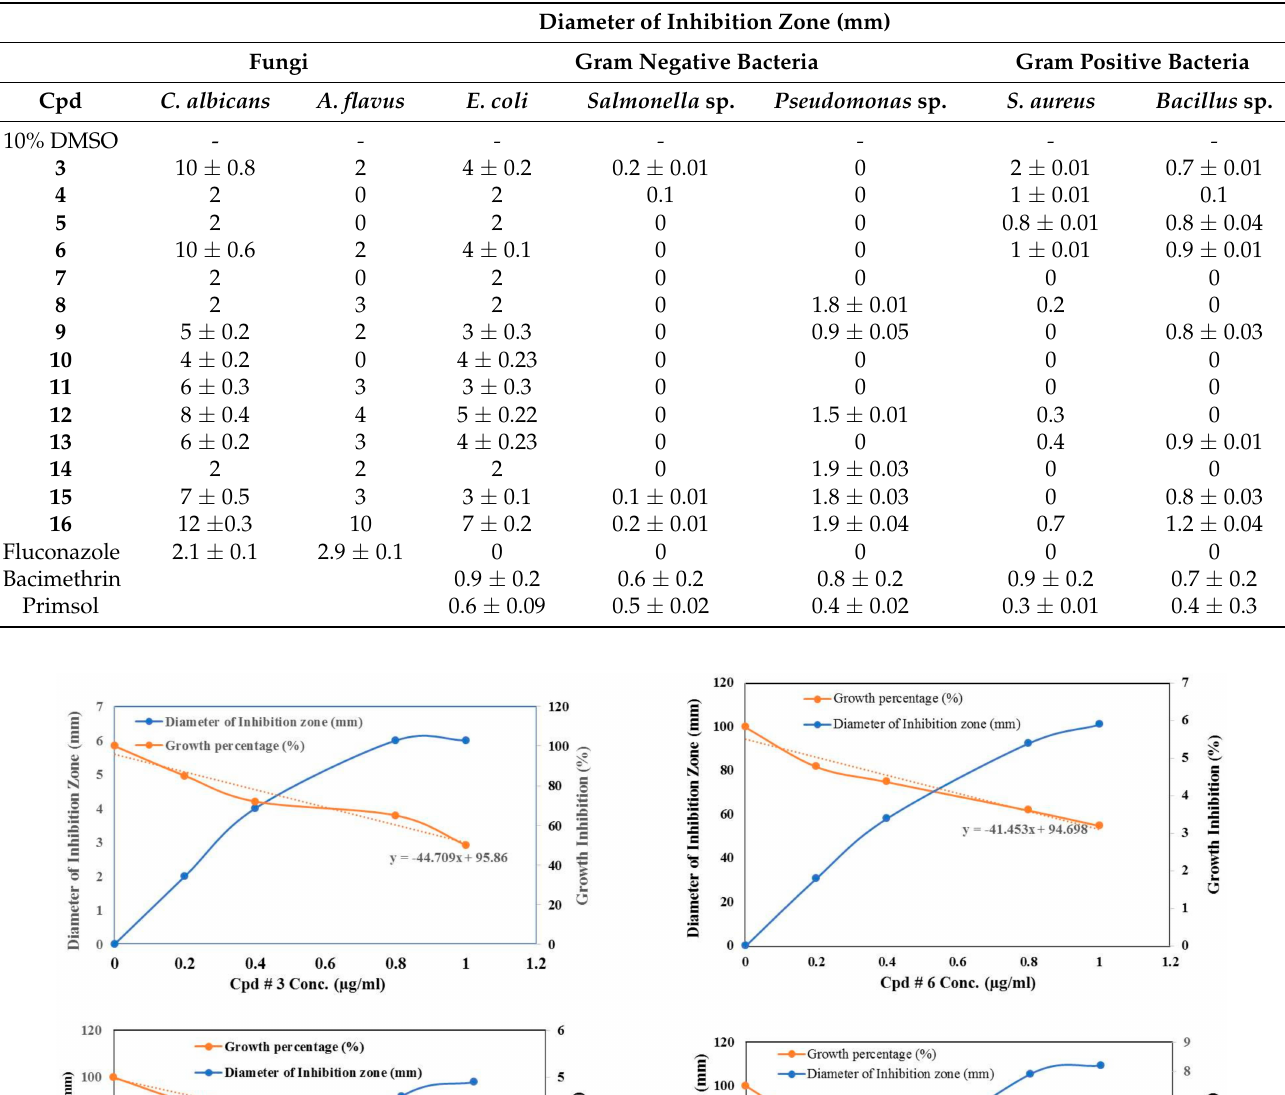
Table 1. Antimicrobial activity of the synthesized derivatives of 3-16 towards C. albicans , A. flavus , E. coli , S. aureus , Pseudomonas sp., and Salmonella sp.